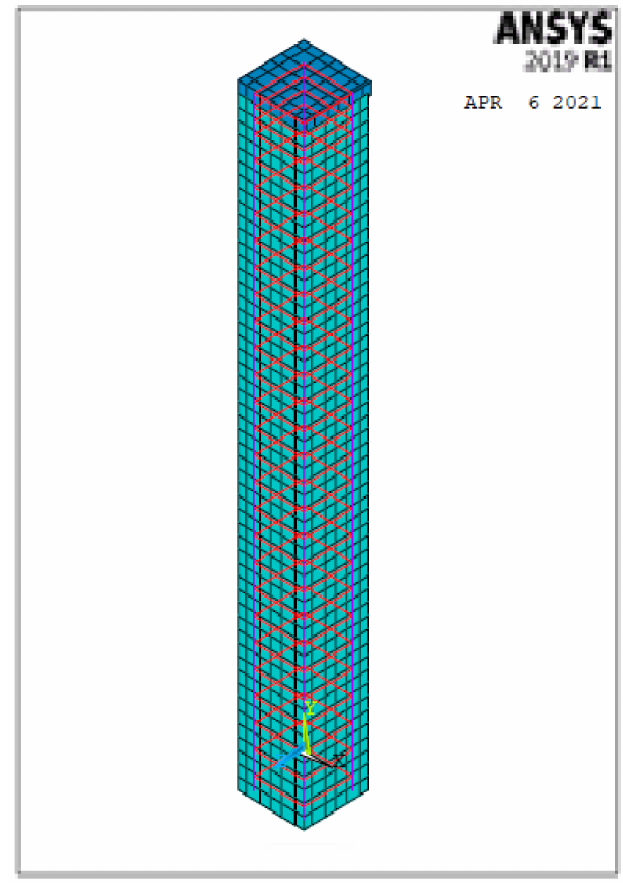
Figure 17. 3D-modeling of the